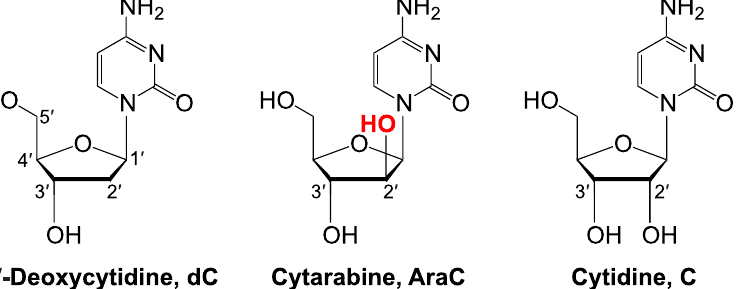
Figure 1. Deoxycytidine, cytarabine, and cytidine nucleosides. Chemical structures of 2 ′ -deoxycytidine (dC, 1- β -D-2 ′ -deoxy-ribofuranosylcytosine), cytarabine (AraC, 1- β -D-arabinofuranosylcytosine), and cytidine (C, 1- β -D-ribofuranosylcytosine). The 2 ′ -OH group in arabinose and ribose sugar moieties points in opposite